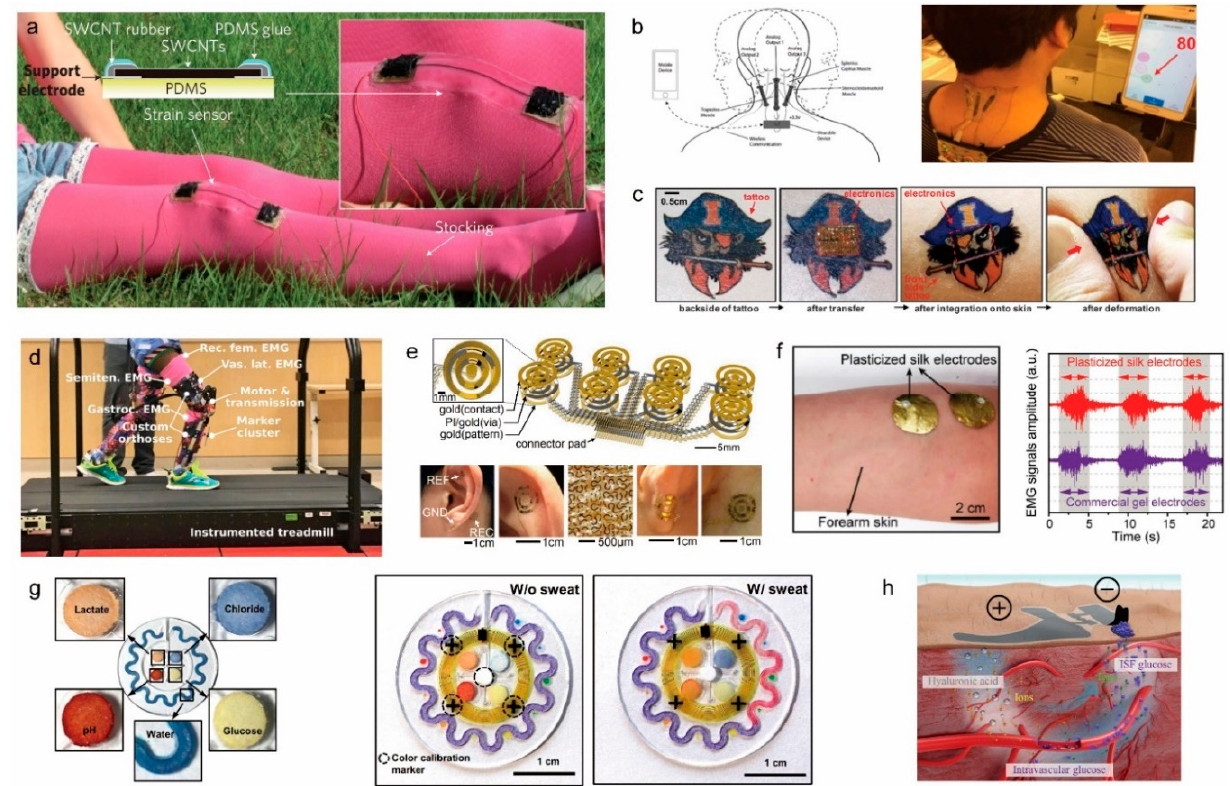
Figure 5. ( a ) A photograph of stretchable carbon nanotube strain sensor attached to clothing to detect physical motion (reprinted with permission from [122]. Copyright 2011 Springer Nature); ( b ) Ionic liquid-based sensor patch of cervical movement detection for directional strain calculation of skin during neck movement (reprinted with permission from [123]. Copyright 2014 Royal Society of Chemistry); ( c ) Commercial epidermal tattoo with the integrated circuit at its backside for multifunctional application (reprinted with permission from [124]. Copyright 2011 American Association for the Advancement of Science); ( d ) Photo of the patient using exoskeleton assisted knee extension on an instrumented treadmill (reprinted with permission from [125]. Copyright 2017 Spring Nature); ( e ) (Top) EEG electrode with a tripolar concentric ring with an integrated capacitive design. (Bottom) Images of ring electrodes on the skin for EEG measurement (reprinted with permission from [126]. Copyright 2015 National Academy of Sciences); ( f ) (Left) A photograph of plasticized silk electrode on human forearm for EMG measurement. (Right) EMG signals obtained by silk electrode during muscle movement with comparison to commercial gem electrodes (reprinted with permission from [127]. Copyright 2018 John Wiley and Sons); ( g ) (Left) Colorimetric detection reservoirs for water lactate, glucose, creatinine, pH, and chloride ions in a wearable microfluidic device. (Right) Images of epidermal microfluidic electrochemical sensor after injection of artificial sweat (reprinted with permission from [128]. Copyright 2016 The American Association for the Advancement of Science); ( h ) Glucose detecting mechanism schematics of a skin-like sensor using an electrochemical twin channel (reprinted with permission from [129]. Copyright 2017 The American Association for the Advancement of Science).